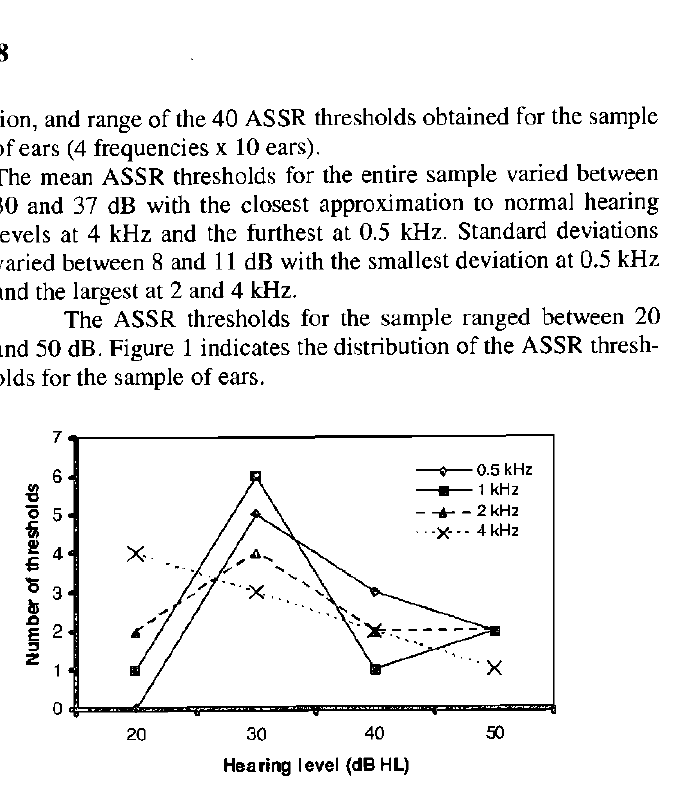
Figure 1. Distribution of ASSR thresholds (n=40) Almost half (45%) of ASSR thresholds were obtained at 30 dB whilst only 18% were obtained at 20 dB. A large propor- tion (38%) of ASSR thresholds for this sample of normal hearing infants were obtained at elevated levels of 40 and 50 dB. Half (50%) of 0.5 kHz thresholds and 30 to 40% of thresholds for the higher frequencies (1 to 4 kHz) were obtained at these elevated intensities (40 to 50 dB).